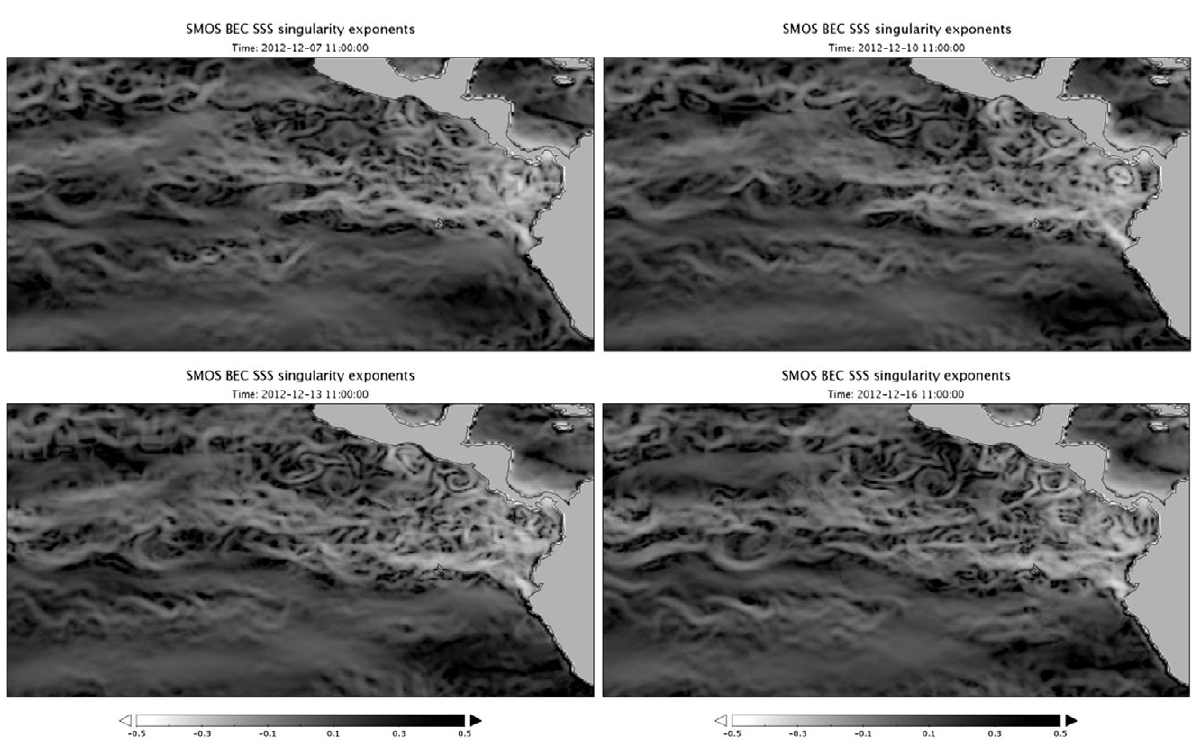
Fig. 14. – Singularity exponents of four 9-day L4 salinity maps in the equatorial Pacific. The plots show the evolution of rings close to the Gulf of